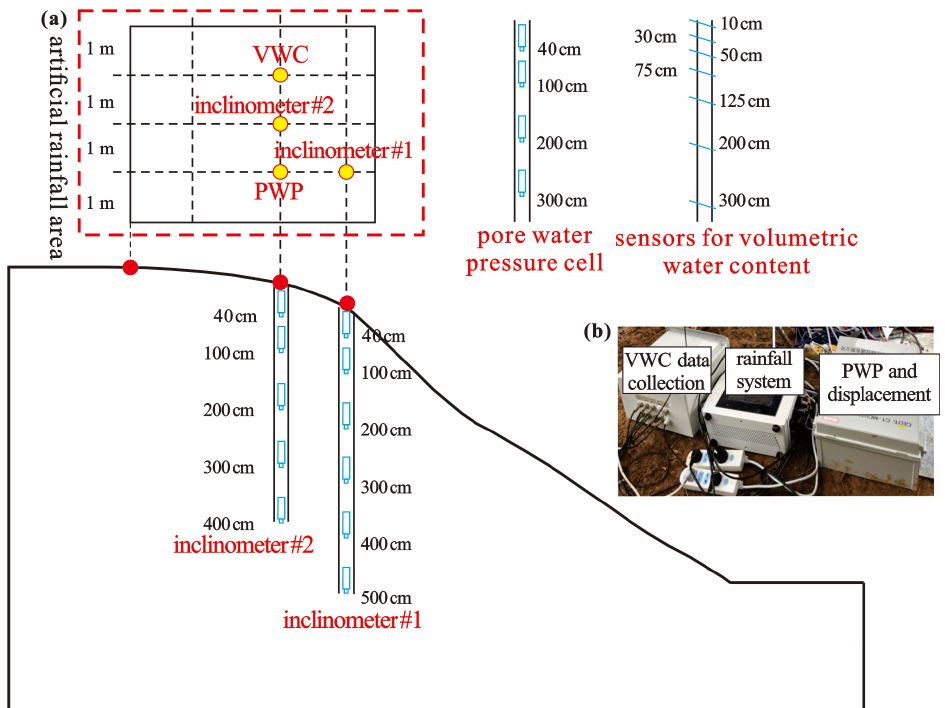
Figure 4. ( a ) Plan and profile setting of the sensors; ( b ) Controlling system of the sensors.